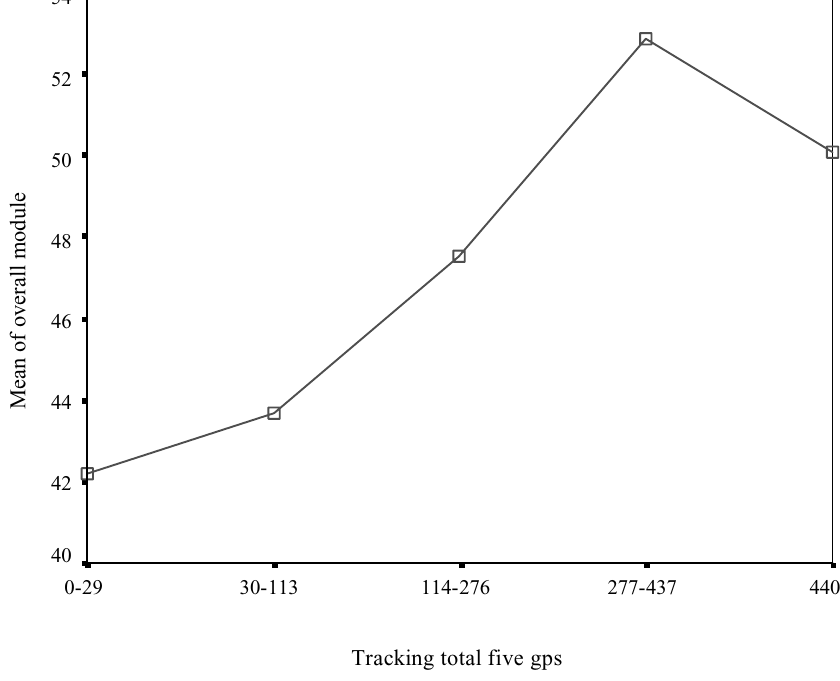
Figure 2. Correlation between online behaviour and assessment performance